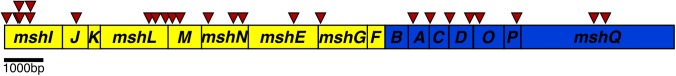
Schematic representation of the transposon insertions in the Msh operons.The operon encoding genes required for assembly and secretion (mshI-F) is displayed in yellow and the operon encoding pilus structural components mshB-Q is displayed in blue. Transposon insertions are indicated by red arrowheads above the operon. There were no identical insertions observed; arrows are shifted up for clarity indicating two insertions near each other.